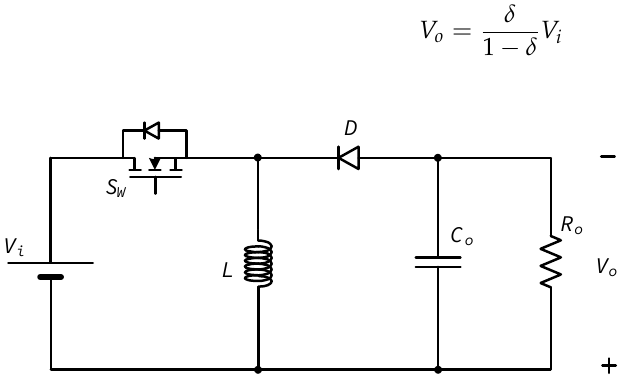
Figure 1. Conventional DC-DC buck-boost converter.